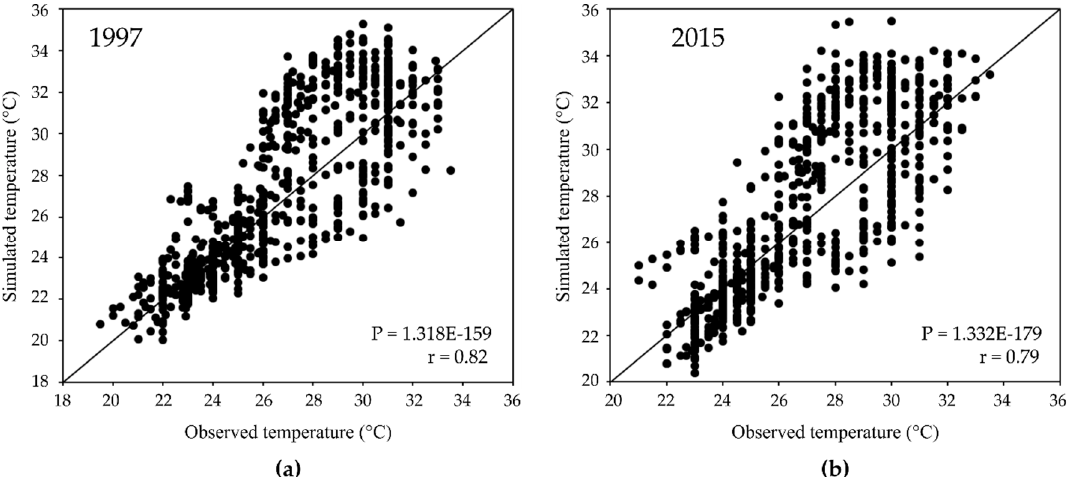
Figure 5. The Pearson correlation coeffiecint between simulated and observed 2 m air temperature in January ( a ) 1997; ( b ) 2015.